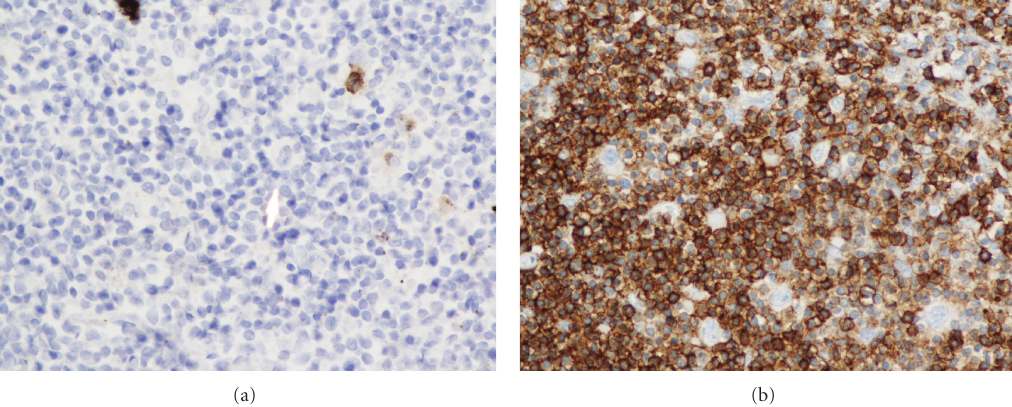
Figure 4: (a) shows large atypical lymphocyte identify by the arrow negative for CD15 (magnification 40x). (b) Immunohistochemistry showing RS cells negative for lymphocyte common antigen (LCA) (magnification